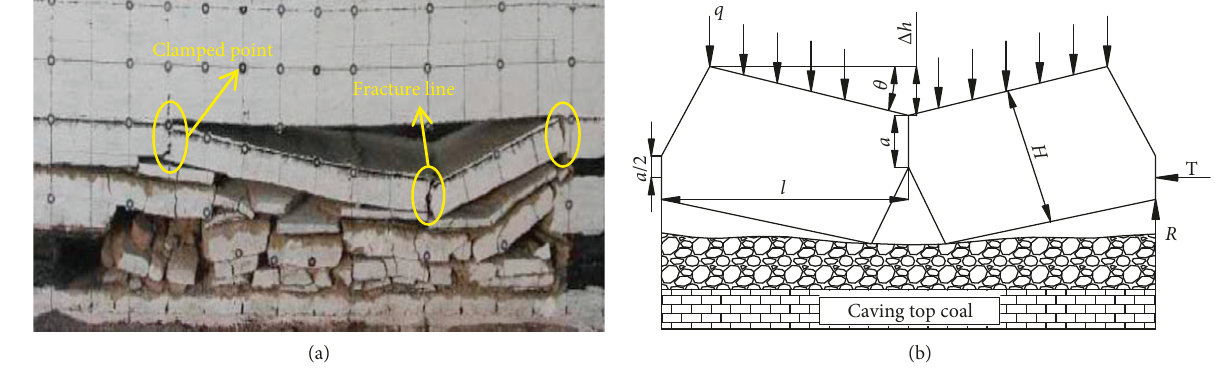
Figure 3: Mechanical analysis on the THR initial